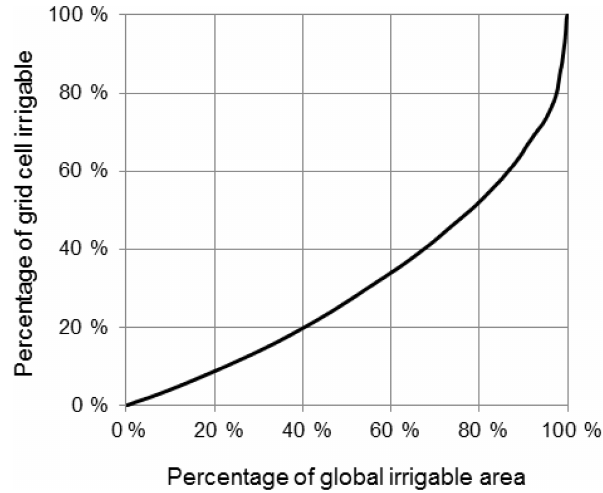
Figure 3. Cumulative distribution curve or quantile plot describ- ing the degree to which the global irrigable area is concentrated. It shows that at 0.05 ◦ grid resolution, almost half of the total global irrigable area occupies less than 25% of a grid